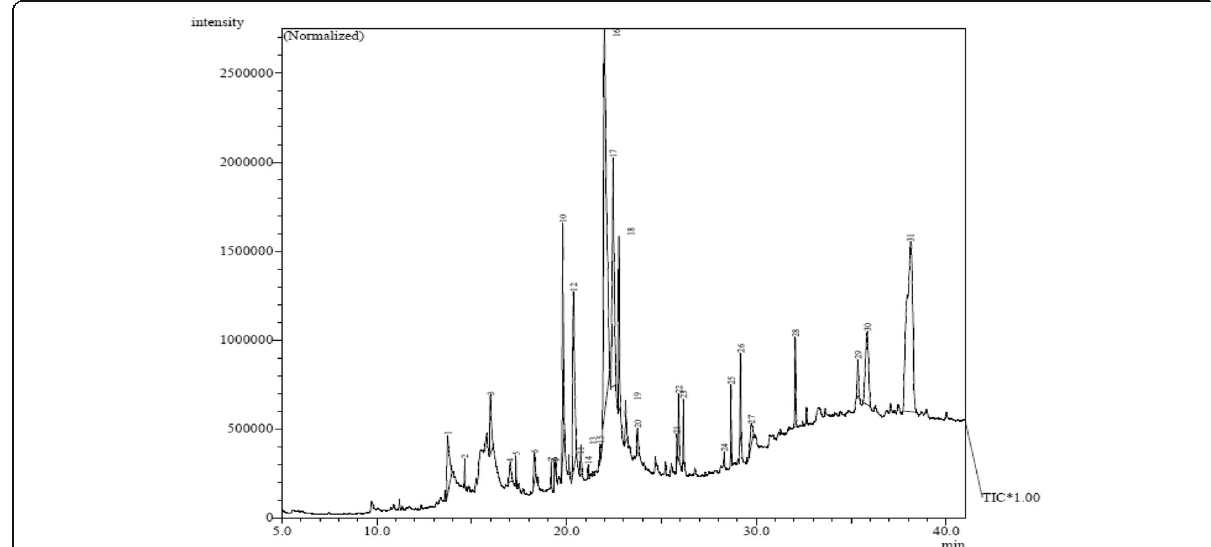
Fig. 6 GC-MS chromatogram for chloroform fraction of S. latifolius